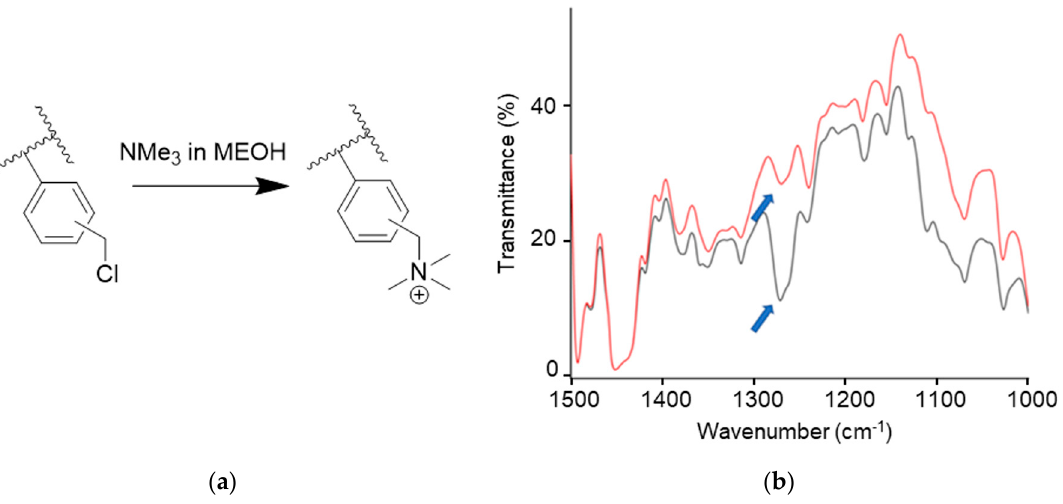
Figure 5. Quaternization reaction of chlorobenzyl groups in the graft copolymers ( a ). FT − IR spectra in the region 1000 − 1500 cm − 1 for the fi lms before (black line) and after (red line) quaternization reaction ( b ).